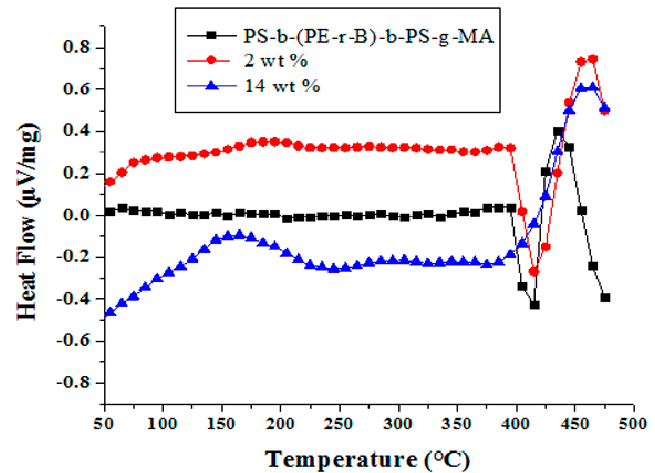
Figure 13. Differential scanning calorimetry (DSC) of neat PS- b -(PE- r -B)- b -PS- g -MA and composites with 2 wt % and 14 wt % Cu-Al 2 O 3 loading.